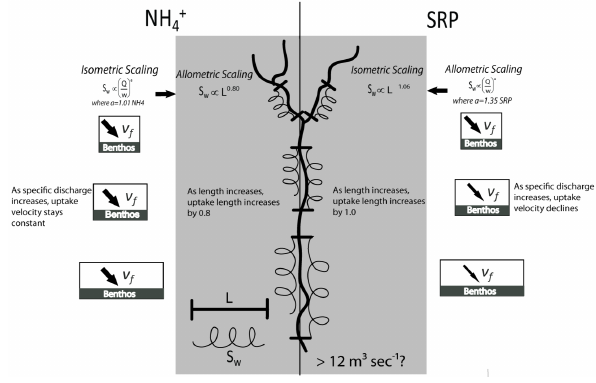
Fig. 4. Conceptual model demonstrates the relationships between scaling of uptake length ( S w ) with stream size (measured as spe- cific discharge, Q/w) and stream length ( L ) for ammonium (NH + and soluble reactive phosphorus (SRP). v f is uptake velocity, the demand for nutrients relative to